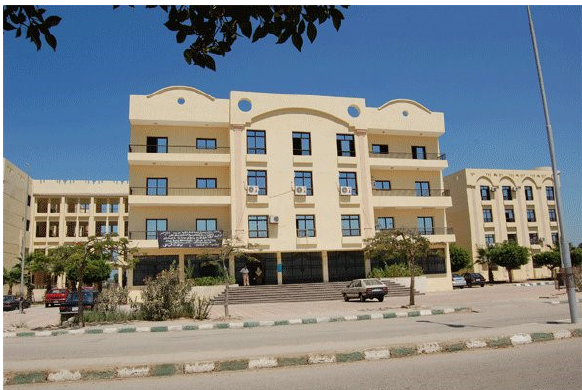
Fig. 1. The area of field experiment (the Colleges Complex in Sebr- bay - Tanta